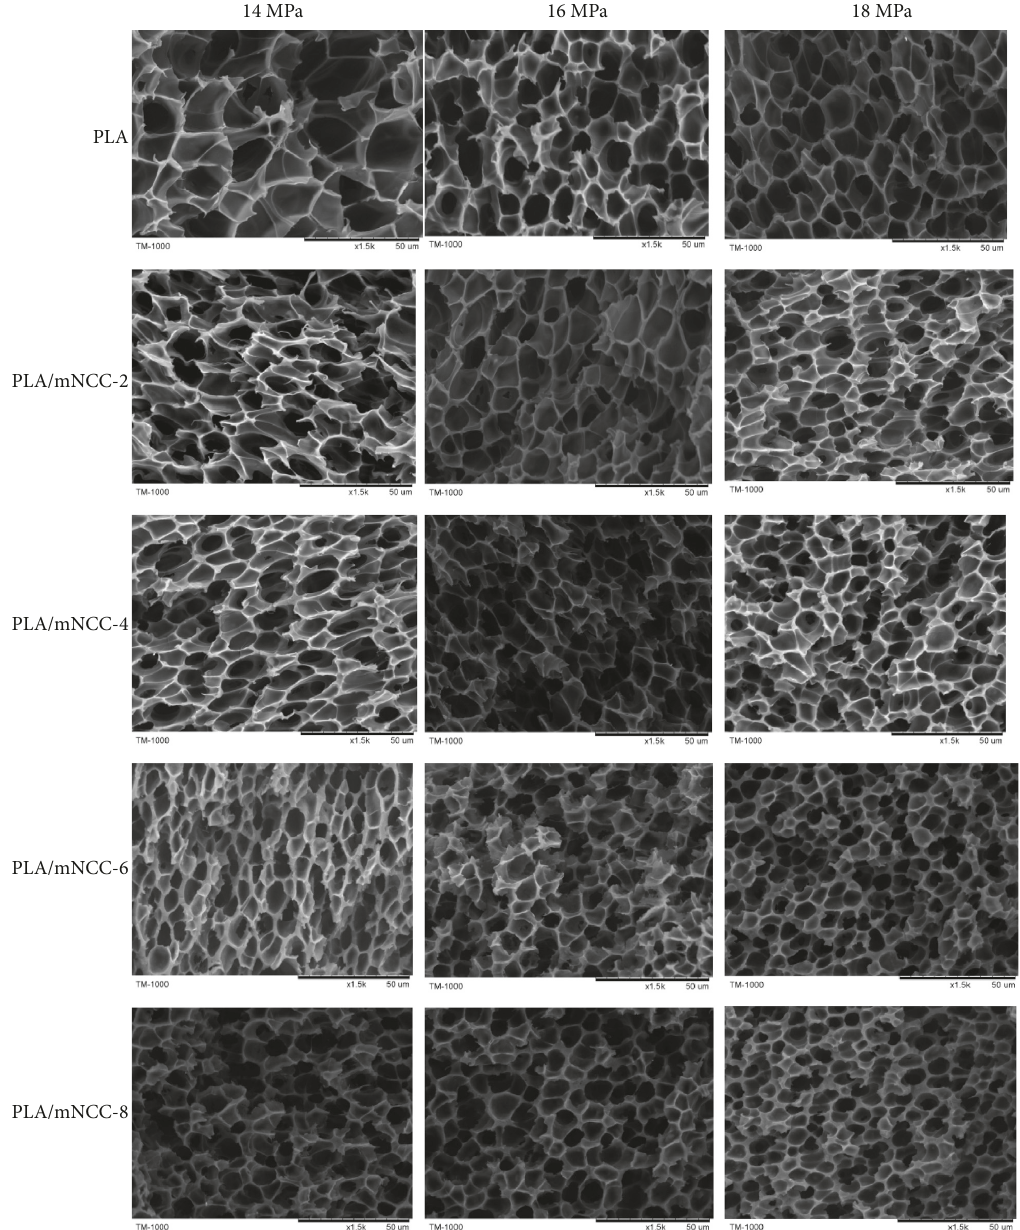
Figure 14: Cell structures of different pressures and different nanoparticle content foaming nanocomposite (110 ° C,